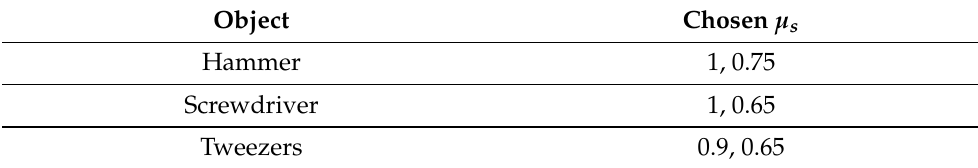
Table 2. Grasp quality measure chosen friction values.